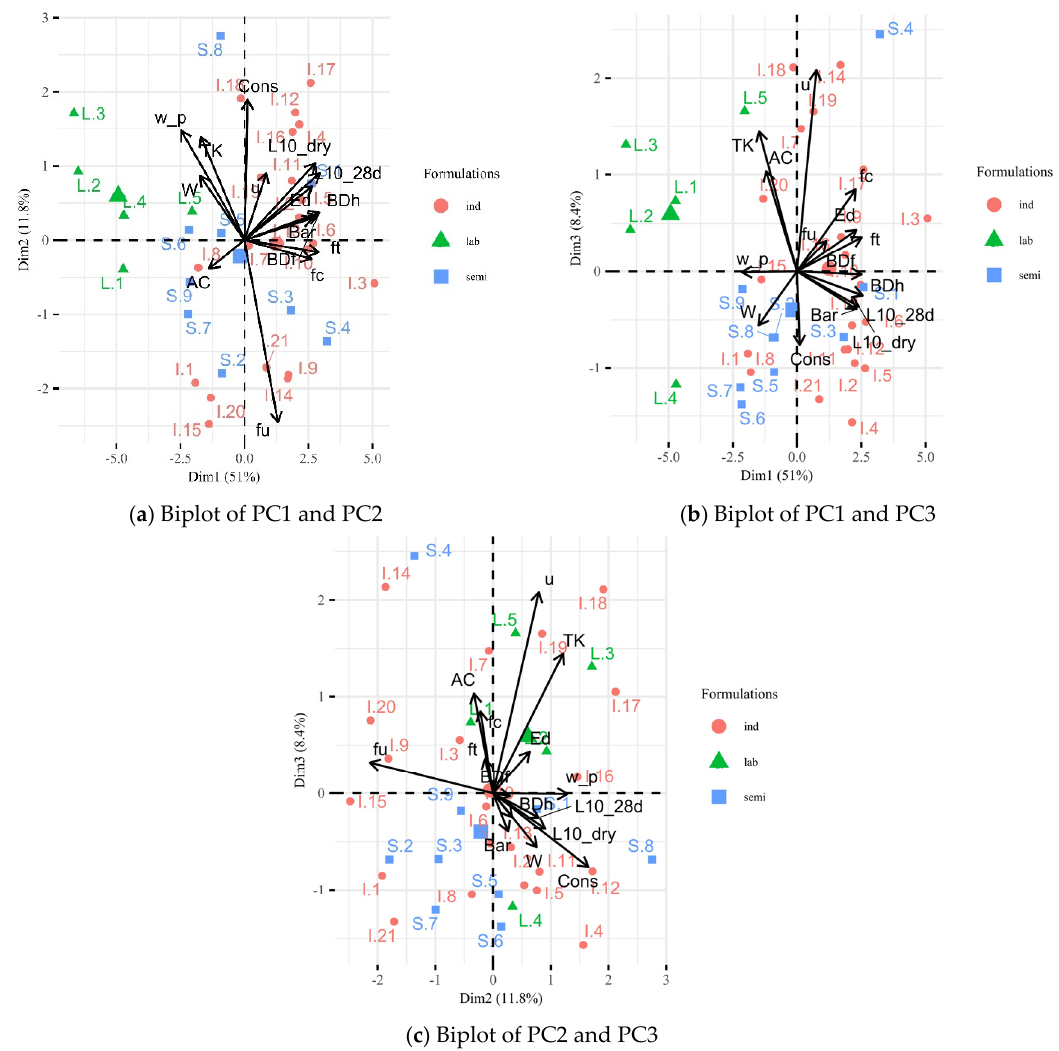
Figure 3. Biplots of PC1, PC2, and PC3 (ind—industrial; lab—laboratory; semi—industrial manipulated in the laboratory)